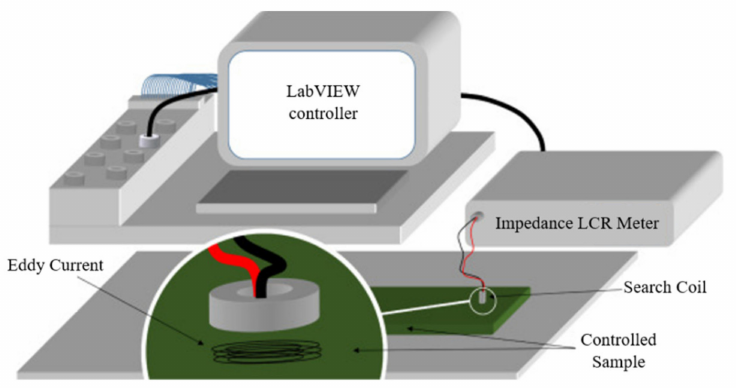
Figure 4. Schematic diagram of eddy current testing